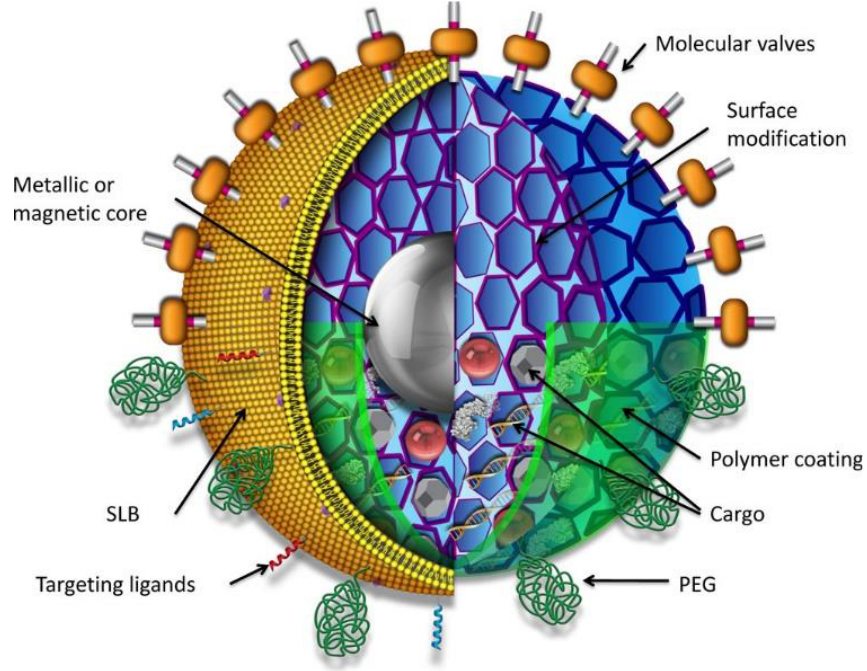
Figure 7. Schematic representation of a multifunctional mesoporous silica nanoparticle showing possible core/shell designs, surface modifications and multiple types of cargoes [193]. Copyright © 2022, American Chemical Society.